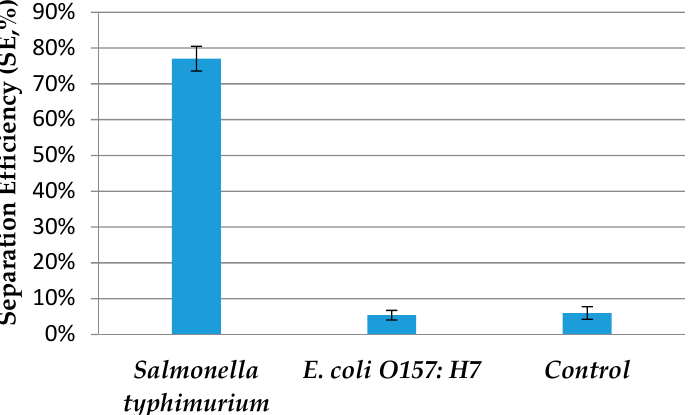
Figure 6. Separation efficiency of salmonella typhimurium and E. coli O157:H7 at a concentration of 10 4 CFU/mL using the proposed device ( N = 3).